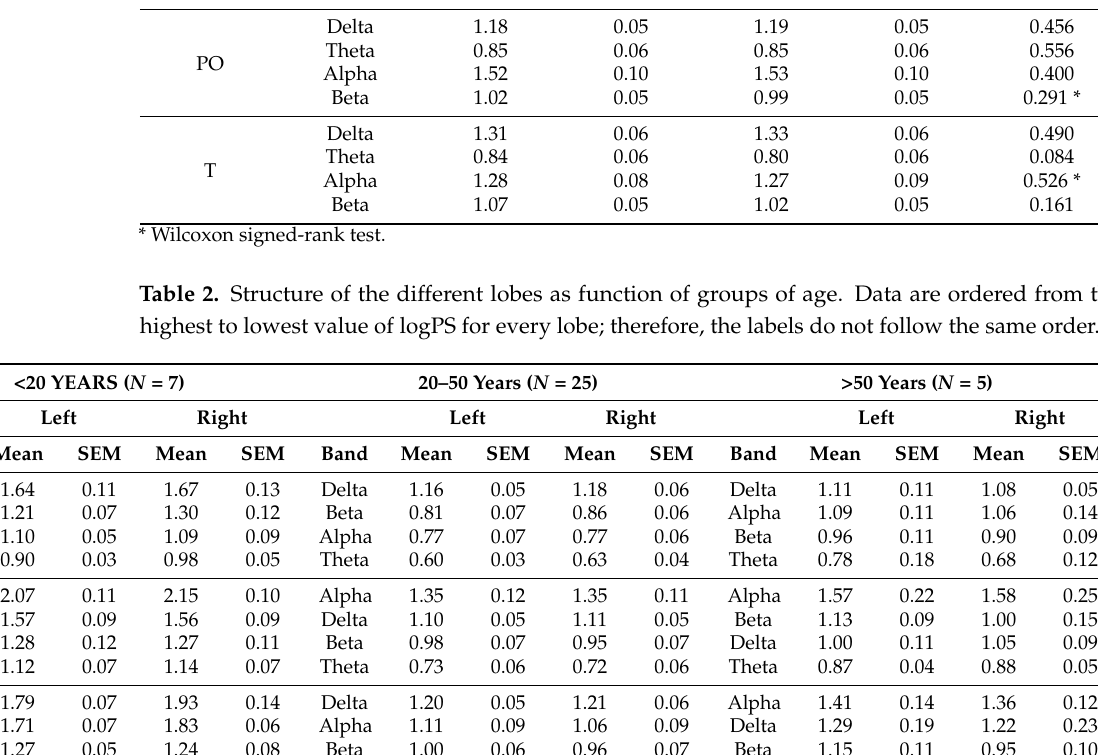
Table 1. Numerical values for the logPS of bands and lobes. Statistical comparison of symmetric lobes by paired Student’s t -test ( N = 37). Lobe Band Left Hemisphere Right Hemisphere p Mean SEM Mean SEM